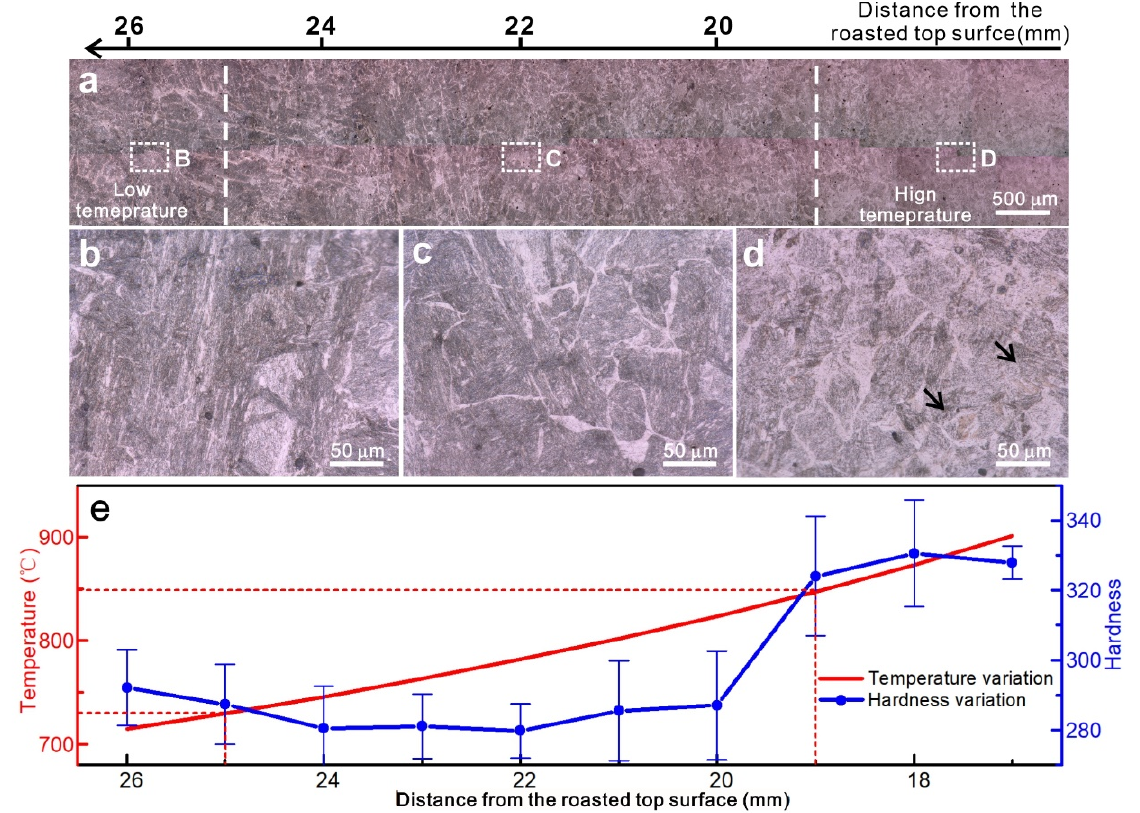
Figure 5. ( a ) Cross-sectional optical micrographs of roasted block. ( b – d ) Optical micrographs of the aeras indicated by ( B – D ) in ( a ). ( e ) Microhardness and the stable temperature variations with the distance from the roasted top surface.